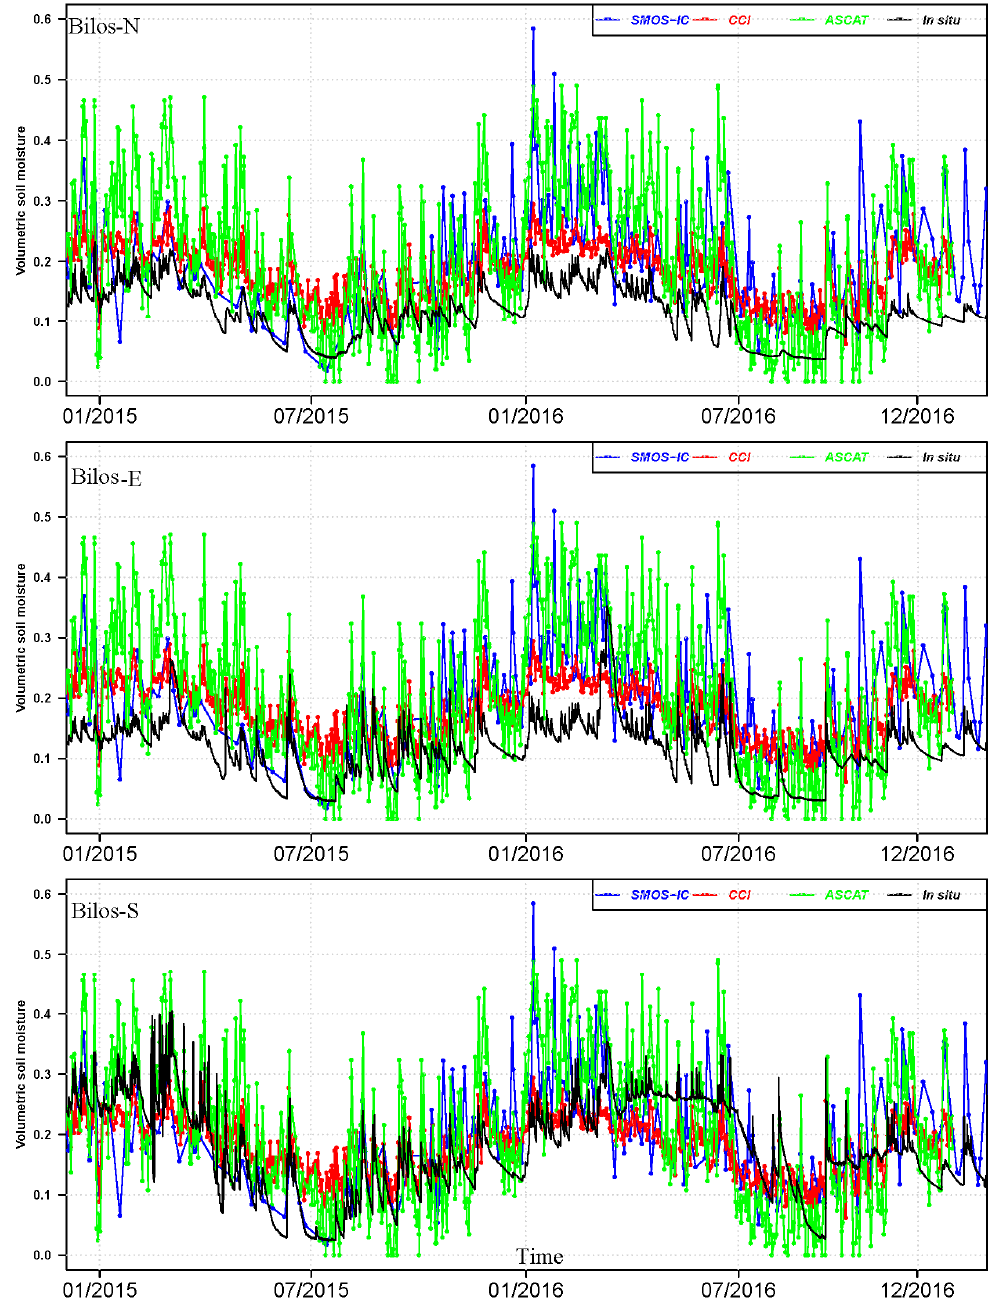
Figure 5. Same as Figure 4 but with the Bilos in situ soil moisture observations.